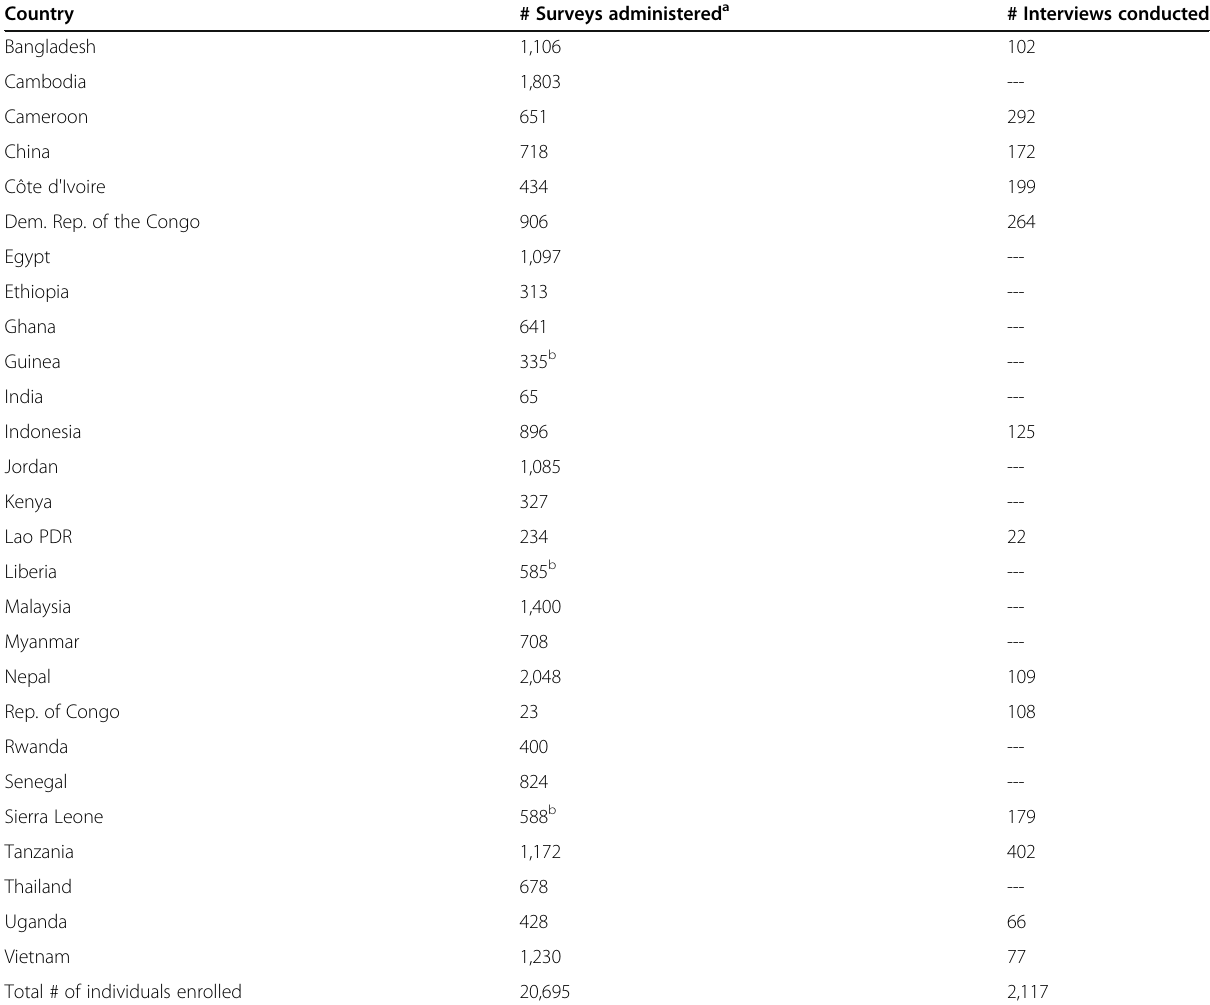
Table 1 Global summary of behavioral data collection